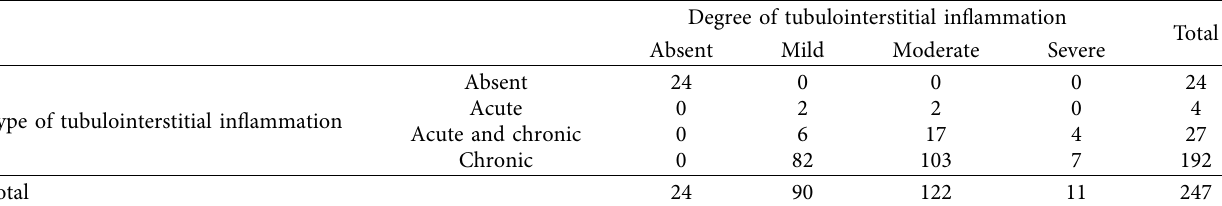
Table 3: Relationship between the type and degree of tubulointerstitial